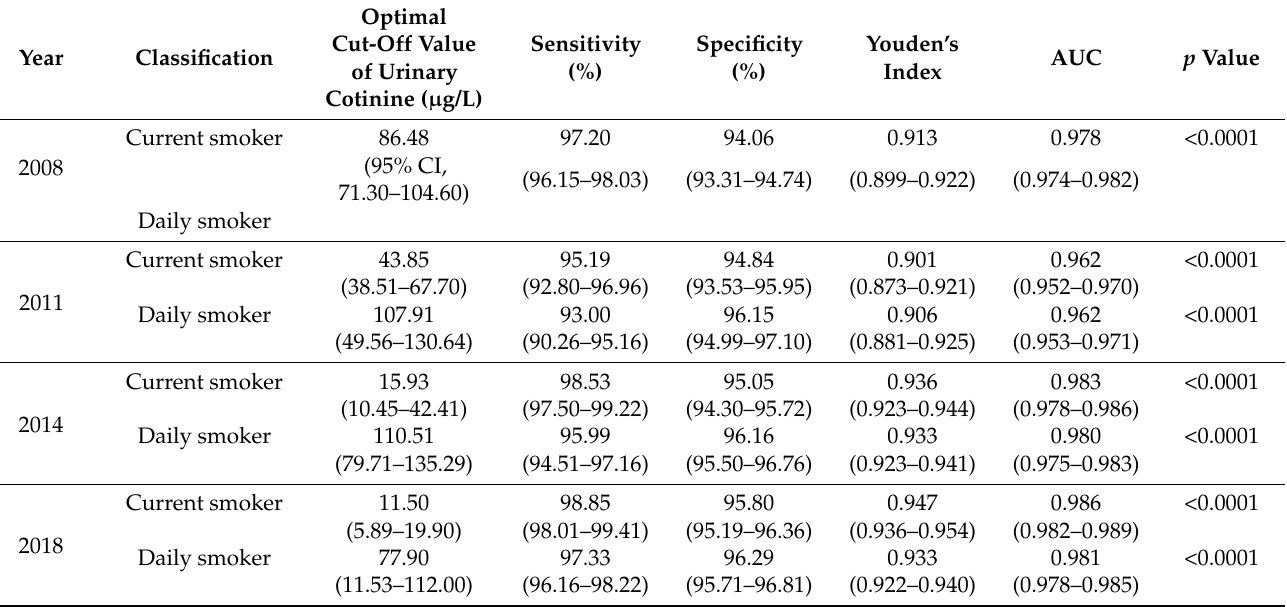
Table 5. The established optimal cut-off values of urinary cotinine concentration for smoking sta- tus